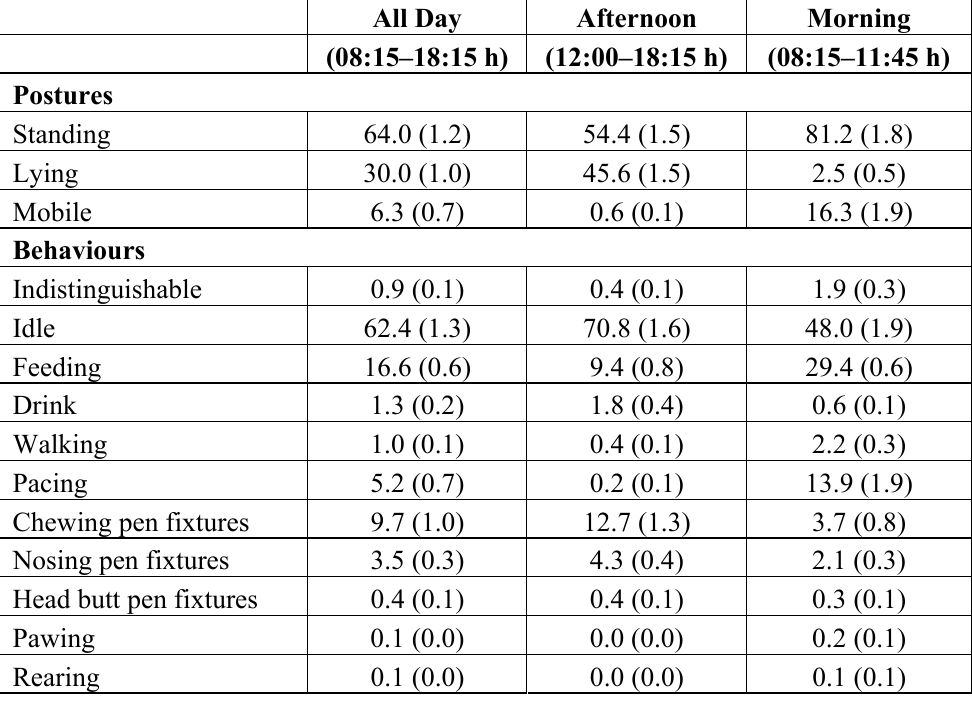
Table 2. Mean percentage of 15-min sample points (from 08:15–18:15 h over the two days of observation) in which sheep displayed individual postures or behaviours. Standard errors of the mean are presented in